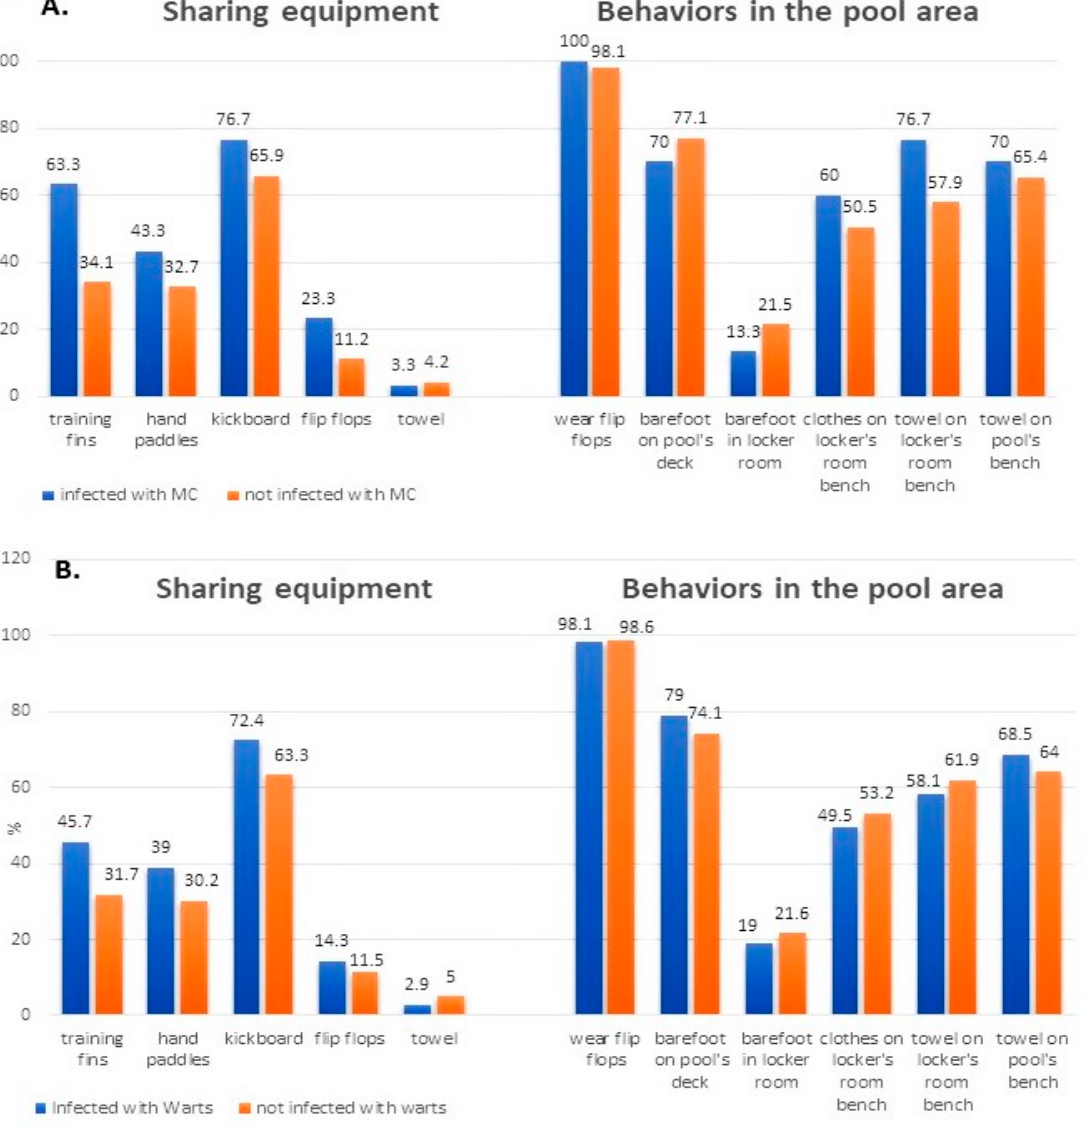
Figure 1. ( A ). Swimmers’ common practices in the pool area and frequencies of those who had or not had infected with Molluscum Contagiosum. ( B ). Swimmers’ common practices in the pool area and frequencies of those who had or not had infected with Warts.